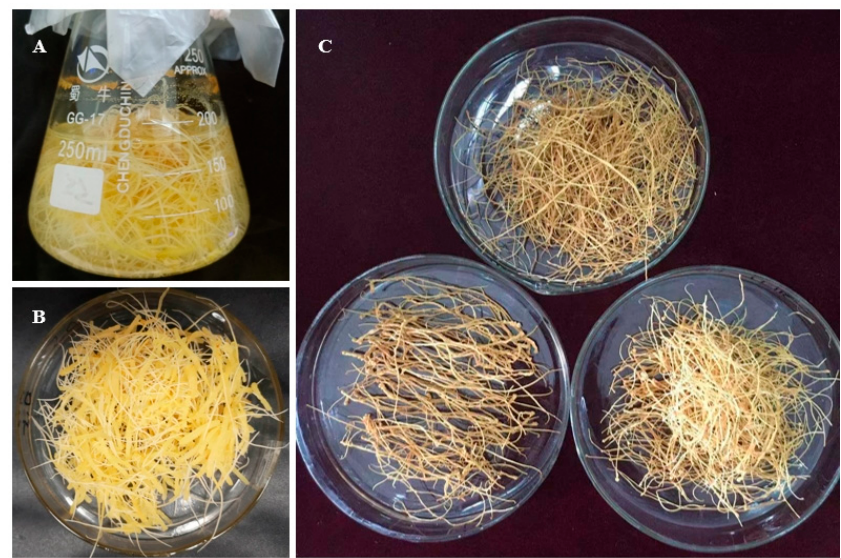
Figure 9. Extraction of ginsenoside from positive ginseng hairy roots. ( A ) Cultivation of single roots of positive ginseng hairy roots using liquid medium. ( B ) Fresh samples of partially positive ginseng hairy roots. ( C ) Partially positive hairy stem samples.